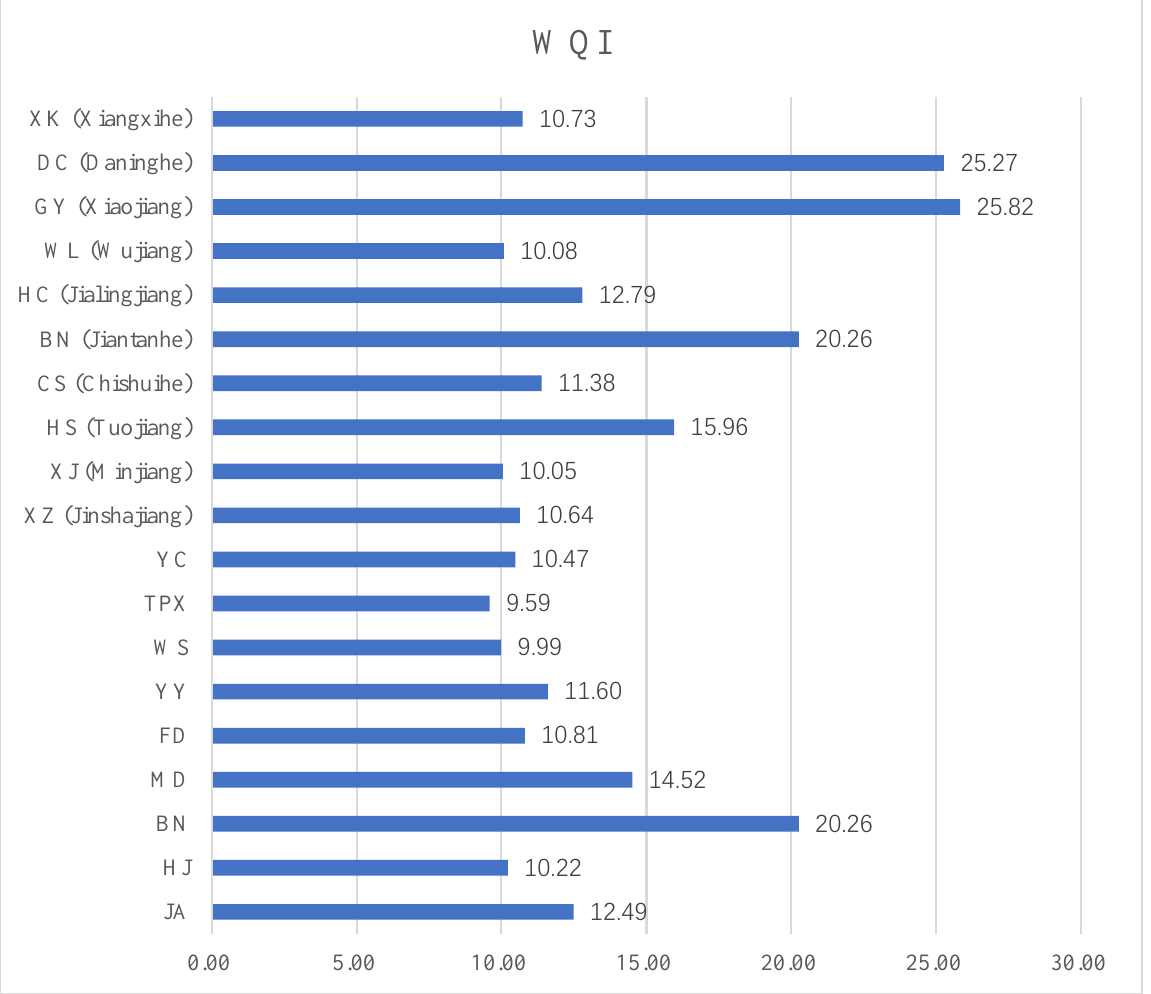
Figure 6. The final WQI value of each sampling location of the Yangtze River. The x-axis is the WQI value and the y-axis is the sampling point.